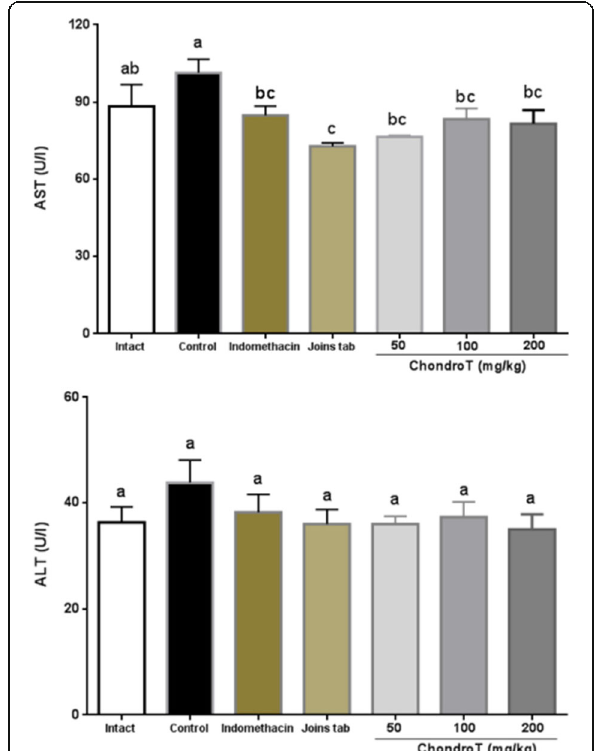
Fig. 6 Changes in serum aminotransferase content after ChondroT administration in collagenase-induced arthritis rats